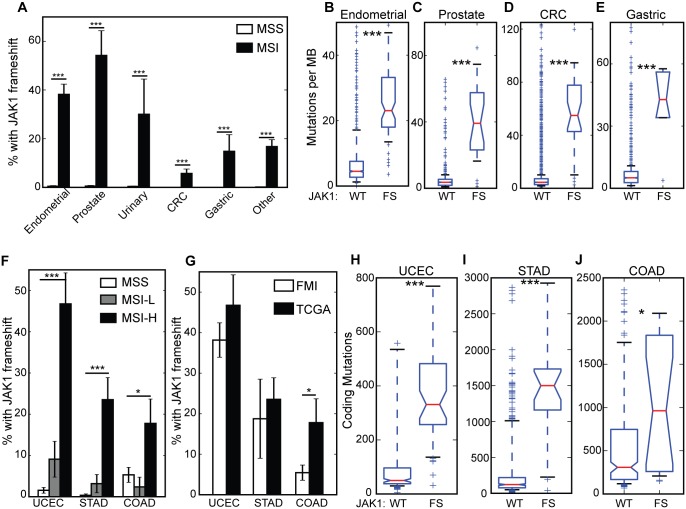
Association of JAK1 frameshifts with MSI and high tumor mutational burden.(A) Frequency of JAK1 frameshifts by tumor type stratified by MSS/MSI-H status. Error bars show standard error. (*** = P < 10−4, Fisher’s exact test) (B-E) Box and whiskers plots of mutations per Mb in (B) endometrial, (C) prostate, (D) CRC, and (E) gastric cancers. The red line defines the median, box defines the quartiles and the whiskers define the 10th and 90th percentiles. The notch in the box provides a 95% confidence interval around the median (*** = P < 10−4, Mann-Whitney U test). (F) Frequency of JAK1 frameshifts by tumor type stratified by MSS/MSI-L/MSI-H status (*** = P < 10−4, * = P < 0.05, Fisher’s exact test). (G) Frequency of JAK1 frameshifts in MSI-H tumors from the FMI and TCGA cohorts (* = P < 0.05, Fisher’s exact test). (H-J) Box and whiskers plots of coding mutations per exome in (H) endometrial, (I) stomach, and (J) colon adenocarcinomas (* = P < 0.05, *** = P < 10−4, Mann-Whitney U test).